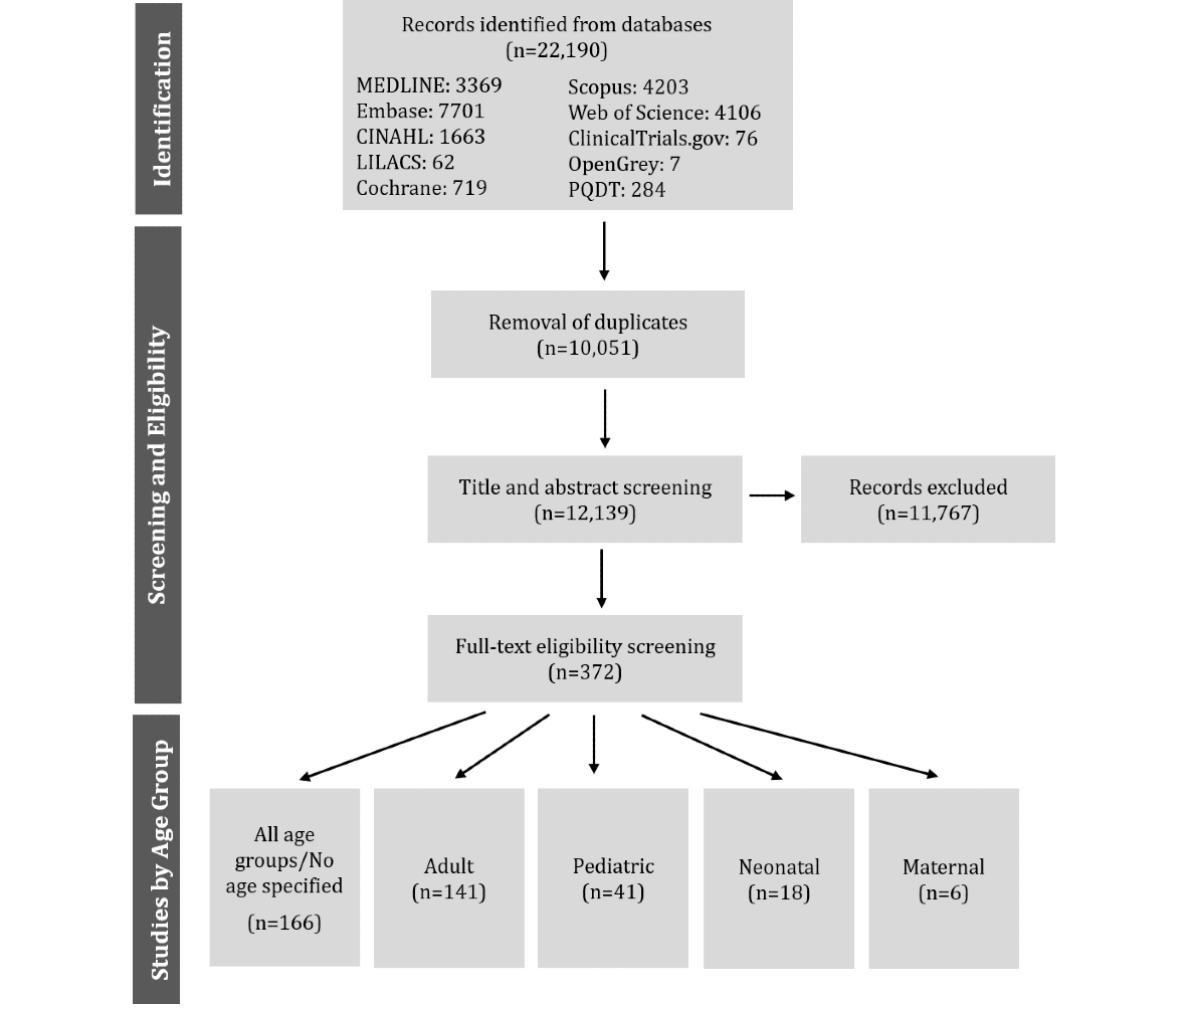
Figure 1. Flowchart of the preliminary search results and screening process. LILACS: Latin American and Caribbean Health Sciences Literature; PQDT: ProQuest Dissertations and